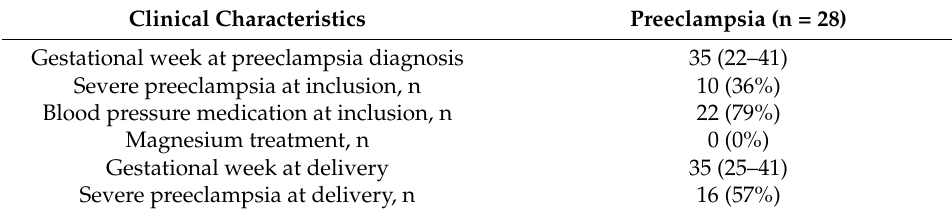
Table 2. Characteristics of the women with